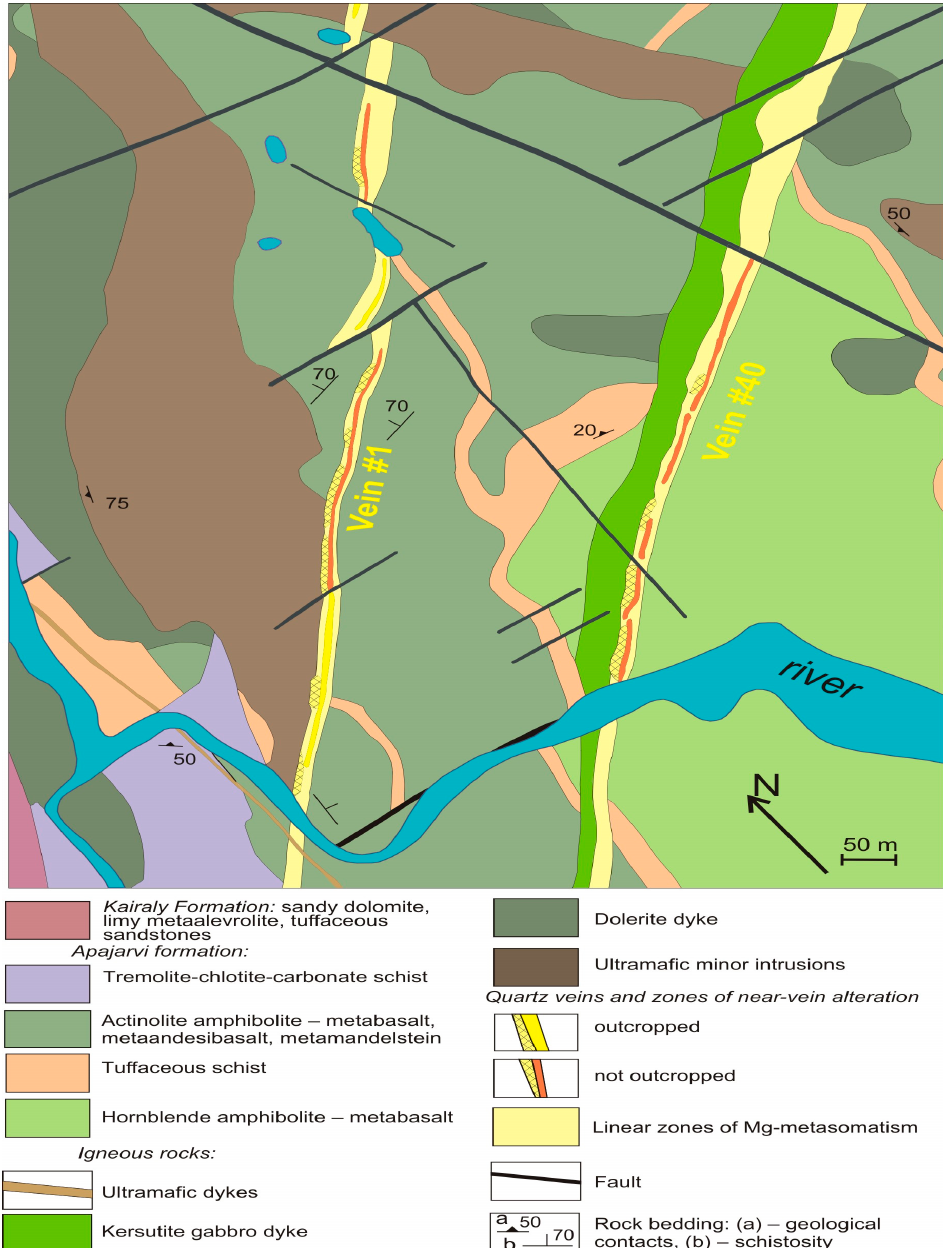
Figure 16. Schematic geological map of the Mayskoe deposit (modelled from Reference [23]).